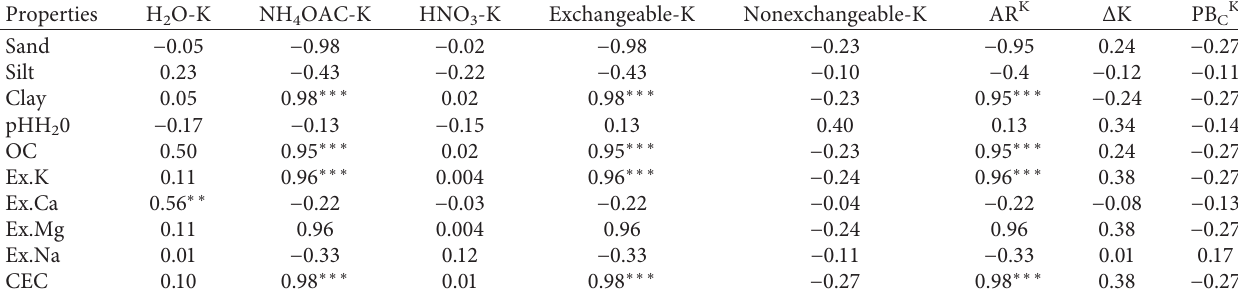
Table 5: Linear coefficients of correlation between potassium forms and quantity-intensity parameters.